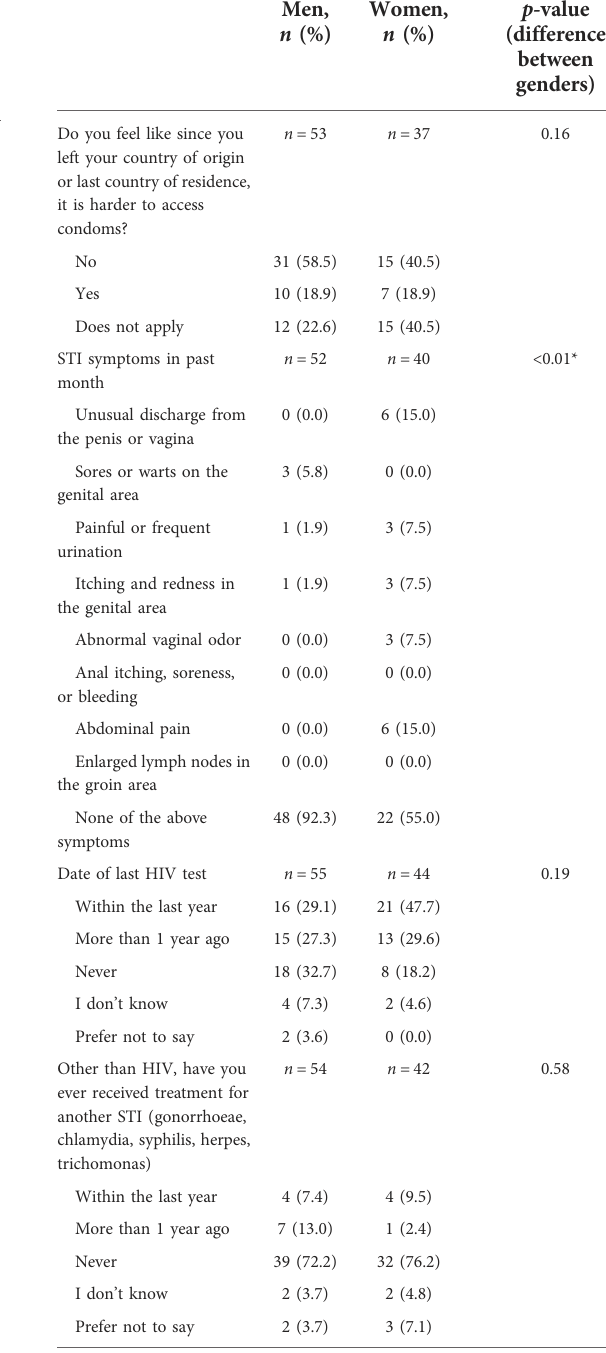
TABLE 2 Sexual behaviors, access to condoms, STI symptoms, and HIV testing (self-reported by adults age ≥ 18